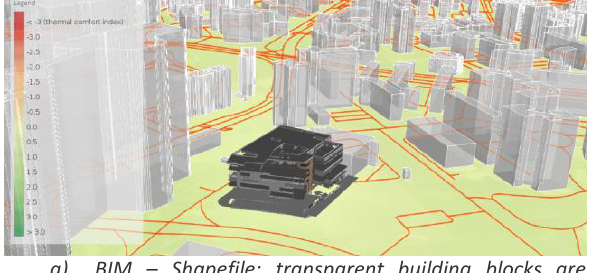
Figure 3: The user interface for QUEST Model